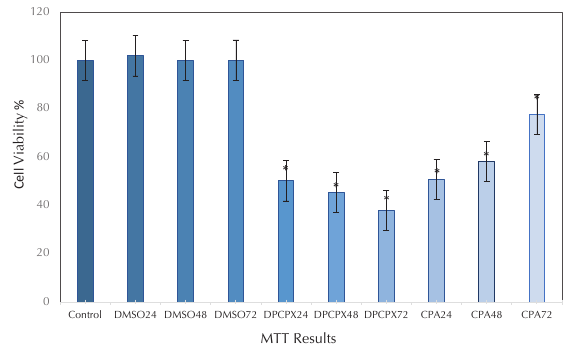
020406080100120 Figure 2. MTT Proliferation Assay in IC50 Concentrations at the Indicated Time After Treatment. Note . The growth rates decreased in treated cells with DPCPX (antagonist) as compared with the untreated cells whereas this rate increased with CPA (agonist) treatment.